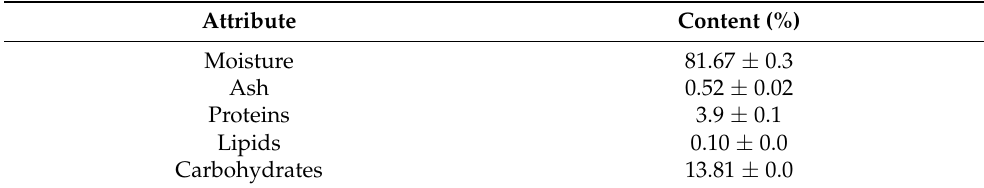
Table 2. Chemical composition of P. insignis